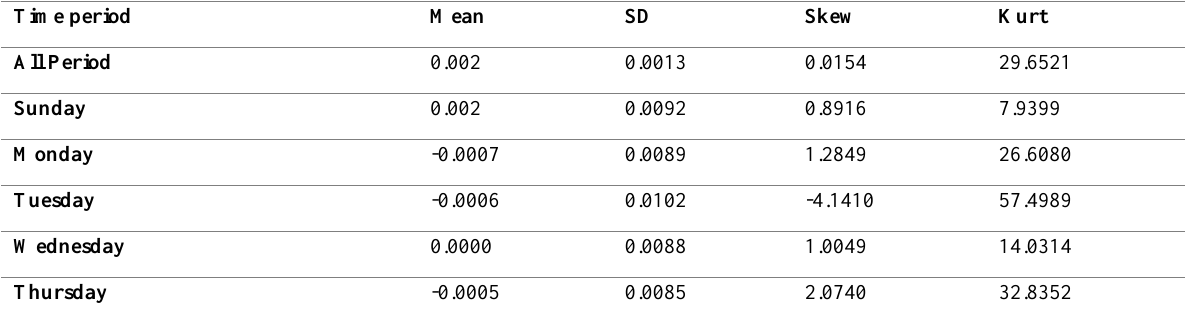
Table 1: Boursa Kuwait Stock Returns (Jan. 2015 – Dec.